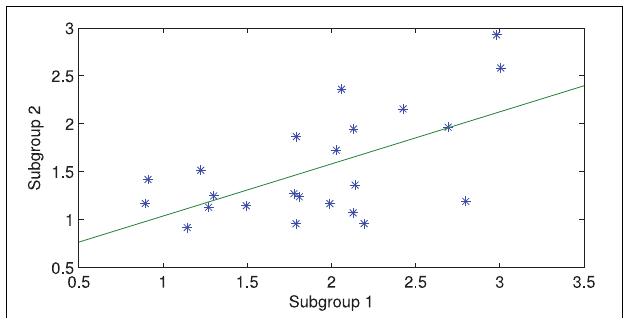
FIGURE 8 | Lateralization index for the language network and comparison with control